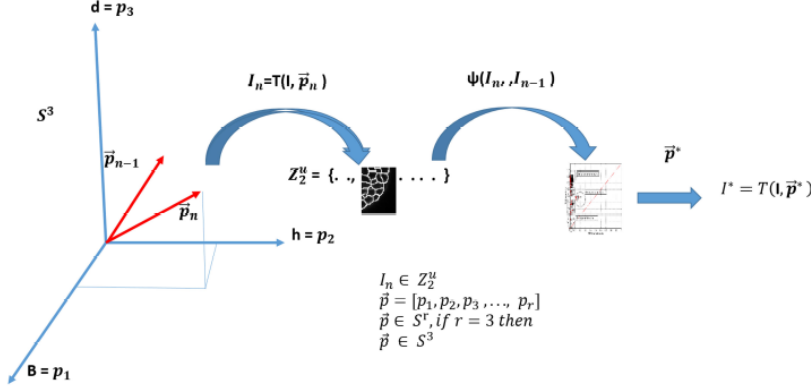
Figure 5. Space of solutions. The segmentation solutions space is three-dimensional, where each coordinate is a segmentation parameter ( B , h , d ) and each space element is a binary image of size u . Each triplet of coordinates is used to generate a u -size binary image.